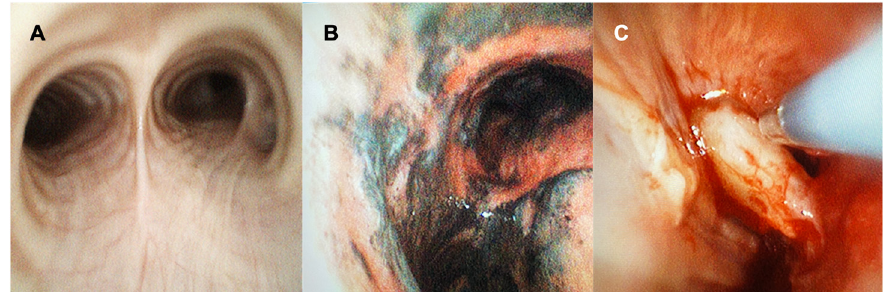
Figure 1. Using SUFB for Airway Inspection and Cryotherapy. This figure demonstrates the use of SUFB (EXALT Model B Single-Use Bronchoscope from Boston Scientific). ( A ) Airway inspection prior to a robotic bronchoscopy procedure for sampling peripheral lung lesions. Secretions were easily suctioned until clean in airways using the SUFB. ( B ) Airway inspection with the view of the main carina using the SUFB in a patient with airway burn. ( C ) Visualization of the airway during cryotherapy with the SUFB.